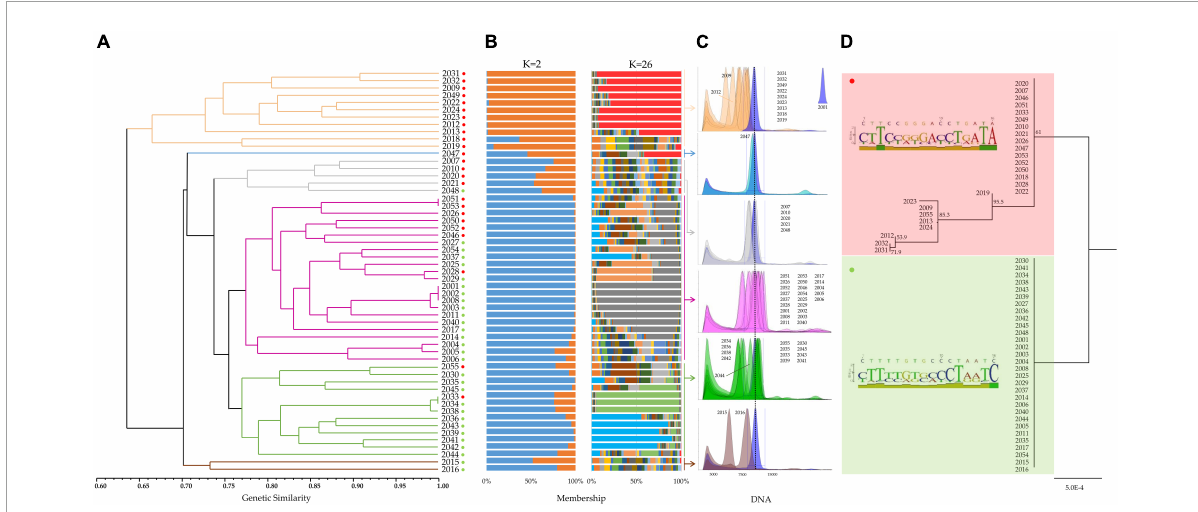
FIGURE4 (A) UPGMA dendrogram based on a pairwise genetic similarity matrix ( Supplementary Table 7 ). Six main clusters highlighted with different colors (ocher, light blue, gray, violet, green, and brown) were found within the germplasm collection of Mandevilla ( n = 55). Red and green dots indicate the membership of each sample to one of the two clusters identified by targeted-region DNA sequencing (D) . (B) Genetic structure of the Mandevilla germplasm collection as estimated by STRUCTURE using the SSR marker dataset. Each sample is represented by a vertical histogram partitioned into K = 2- and K = 26-colored segments that represent the estimated membership ( Supplementary Figure 1 ). The proportion of ancestry (%) is reported on the abscissa axis. (C) DAPI-based flow cytometry measurements of the 55 Mandevilla accessions. Each sample was analyzed by co-staining its nuclei along with those extracted from 2001 (the reference sample whose degree of ploidy was known, i.e., triploid). Samples were then grouped and analyzed according to the six clusters identified in panel (A) . (D) Neighbor-joining tree built by concatenating the ITS1 and rbc L sequences of each sample and aligning them through the Clustal omega algorithm. Bootstrap values are reported. For each of the two groups identified through DNA barcoding ( rbc L) and DNA haplotyping (ITS1), in the left part of the panel, a polymorphic site-based sequence logo is